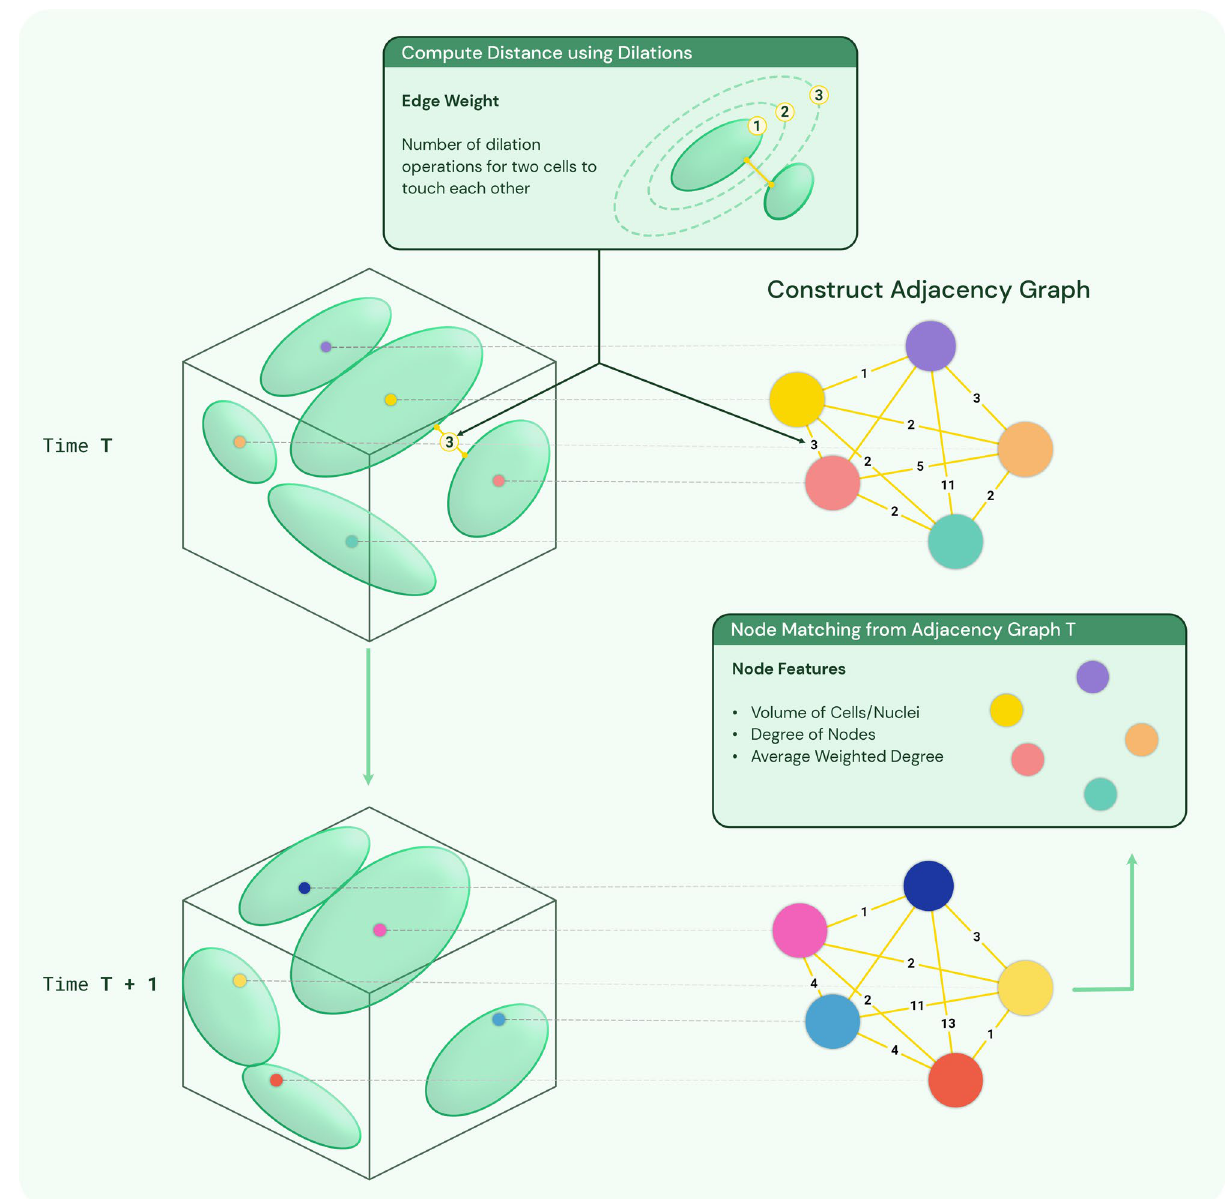
Figure 3. Constructing adjacency graph from the segmentation image and tracking cells/nuclei in consecutive frames using adjacency graph node features. Color of nodes denote the label/track of the cell/nuclei. Initially, random labels are assigned for each node in the adjacency graph. For T + 1 frame, after node matching for time T, track IDs are assigned to each node in T +